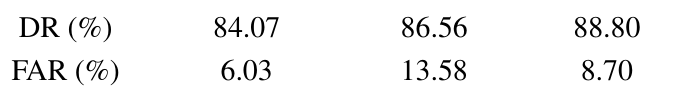
Table 4. Performance of the: ( a ) naive Bayes, ( b ) SVM and ( c ) AdaBoost classifiers in terms of the detection rate (DR) and false alarm rate